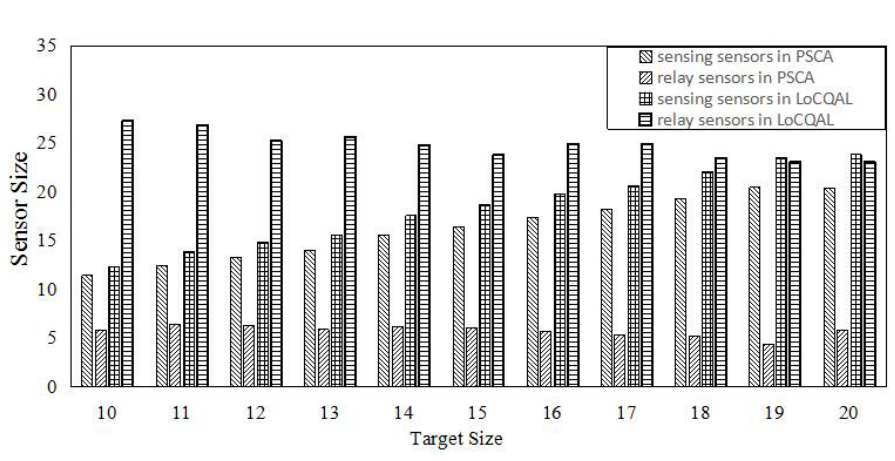
Figure 13. Impact of target size on PSCA and LoCQAL. One hundred and fifty sensors are deployed in